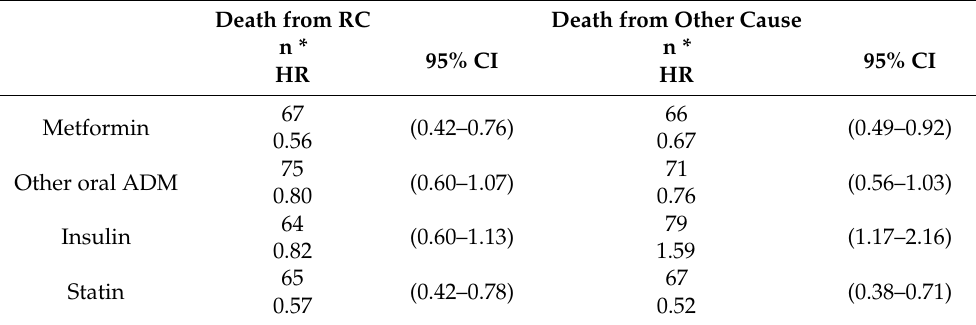
Table 3. Hazard ratios and 95% confidence intervals (in parentheses) for post-diagnostic cancer- specific mortality and mortality from other causes in relation to medication. ADM = antidiabetic medication, RC = rectal cancer, HR = hazard ratio, 95% CI = 95% confidence